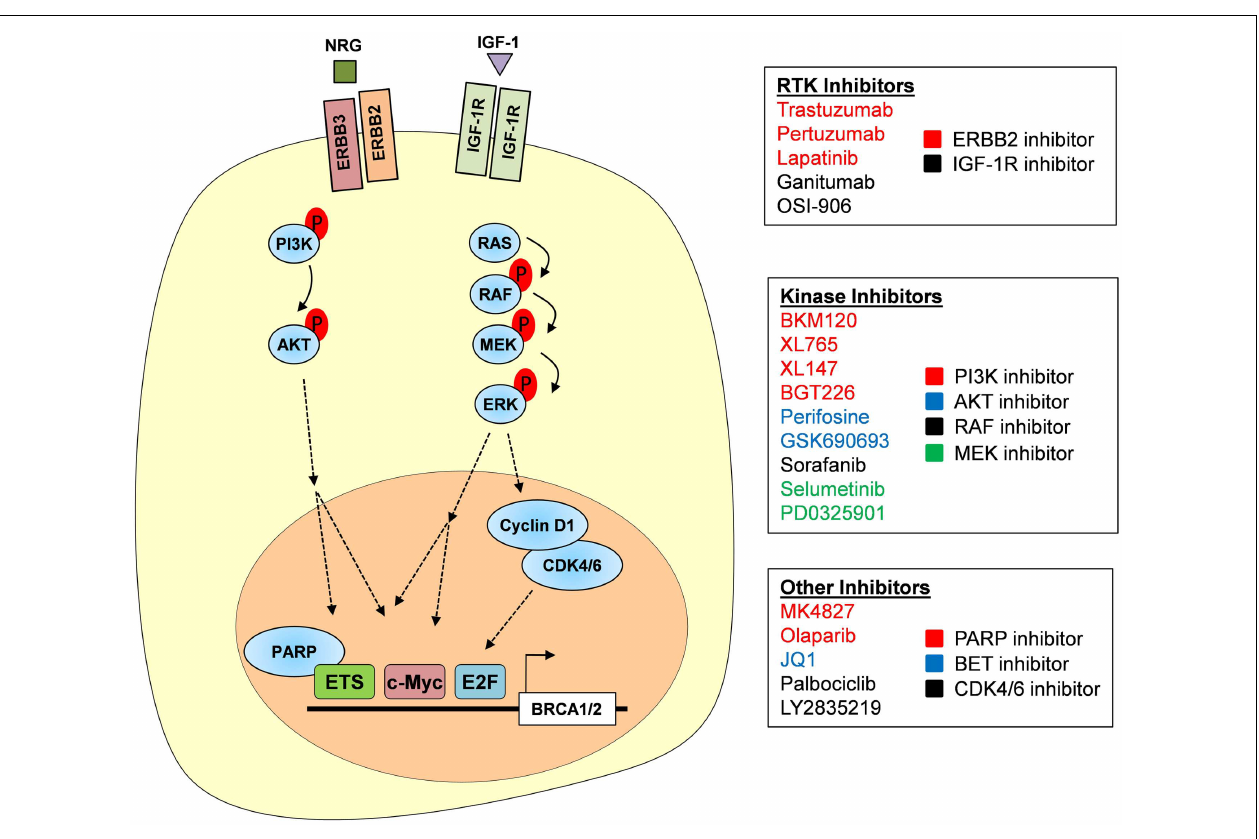
D1 production, which in complex with CDK4/6 promotes E2F-mediated gene transcription.We propose that BRCA1 and BRCA2 expression could be inhibited at each of these levels; inhibitors of RTKs, PI3K signaling, MAPK signaling, and CDK4/6 are listed. PARPi, such as Olaparib, may also downregulate BRCA gene expression as PARP1 is required as a co-factor for some ETS family